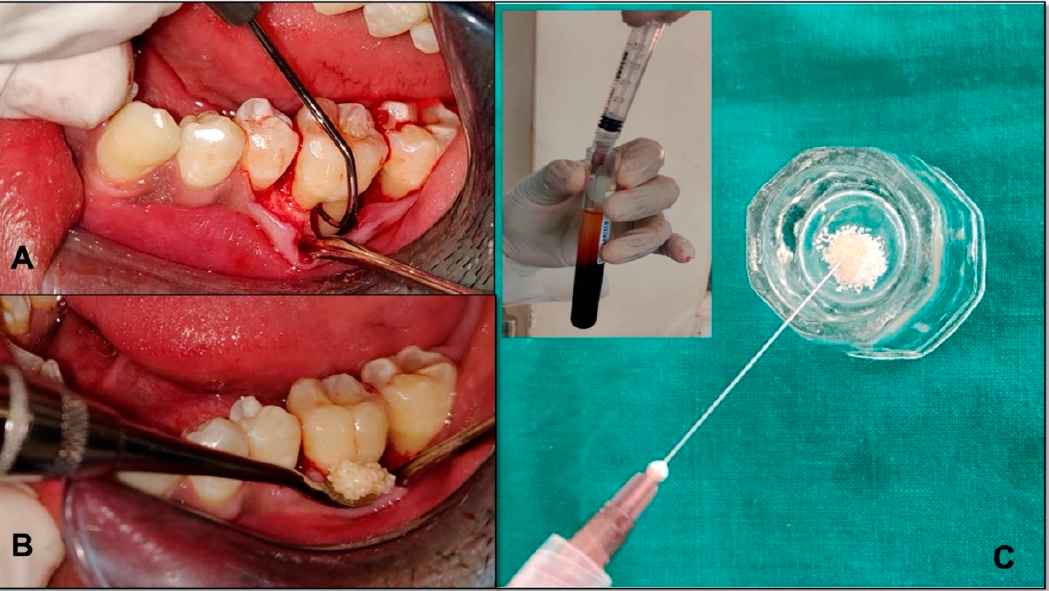
Figure 1. ( A ) Grade II furcation involvement; ( B ) i-PRF collection from the test tube (insight) and